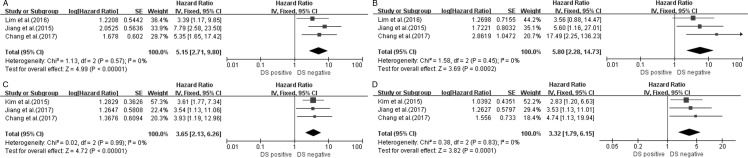
Forest plots of HR for PFS and OS with DS (A, PFS; B, OS) of I-PET/CT and DS (C, PFS; D, OS) on E-PET/CT.